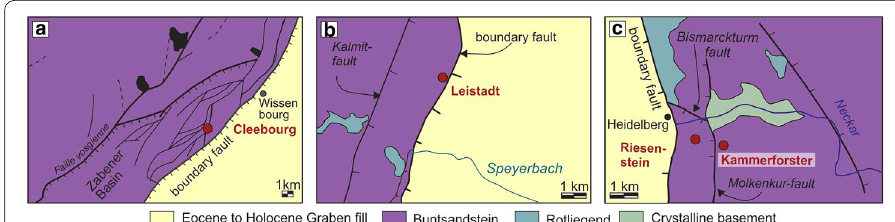
Fig. 2 Geological maps of the outcrops studied on the western graben shoulder, a Cleebourg and b Leistadt, and on the eastern graben shoulder, c Riesenstein and Kammerforster (maps modified after Eisbacher